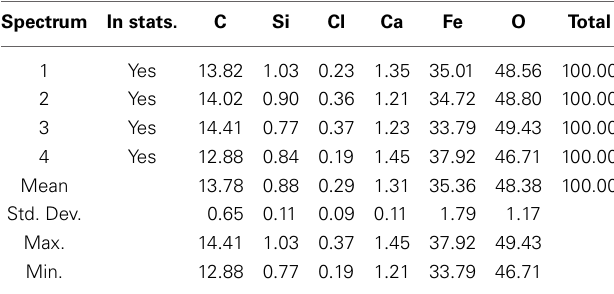
Table 3 | Elemental composition of ochre samples treated with GS and SD and control samples, as determined using XRF analysis.